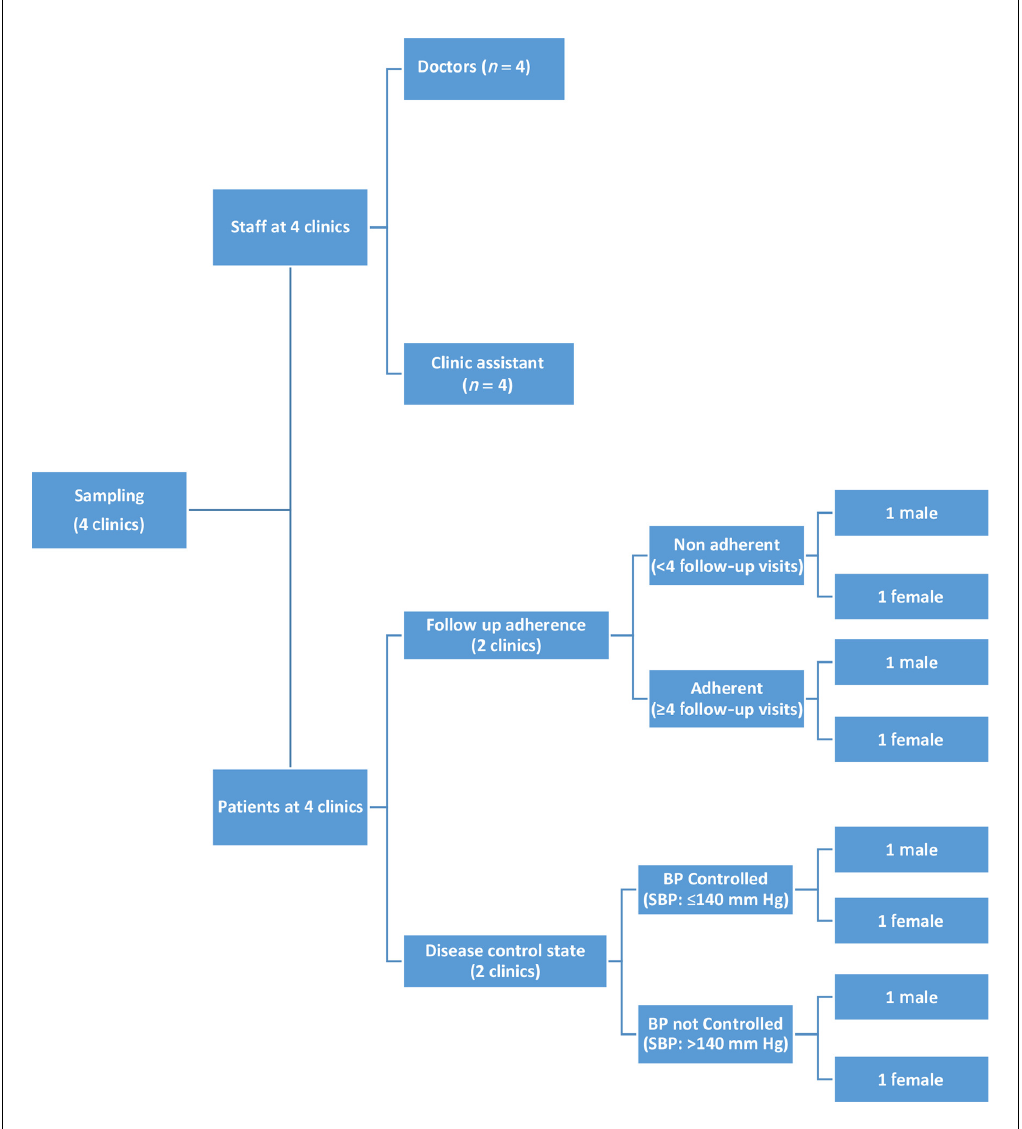
Figure 1. Sampling for staff and patient interviews. SBP = systolic blood